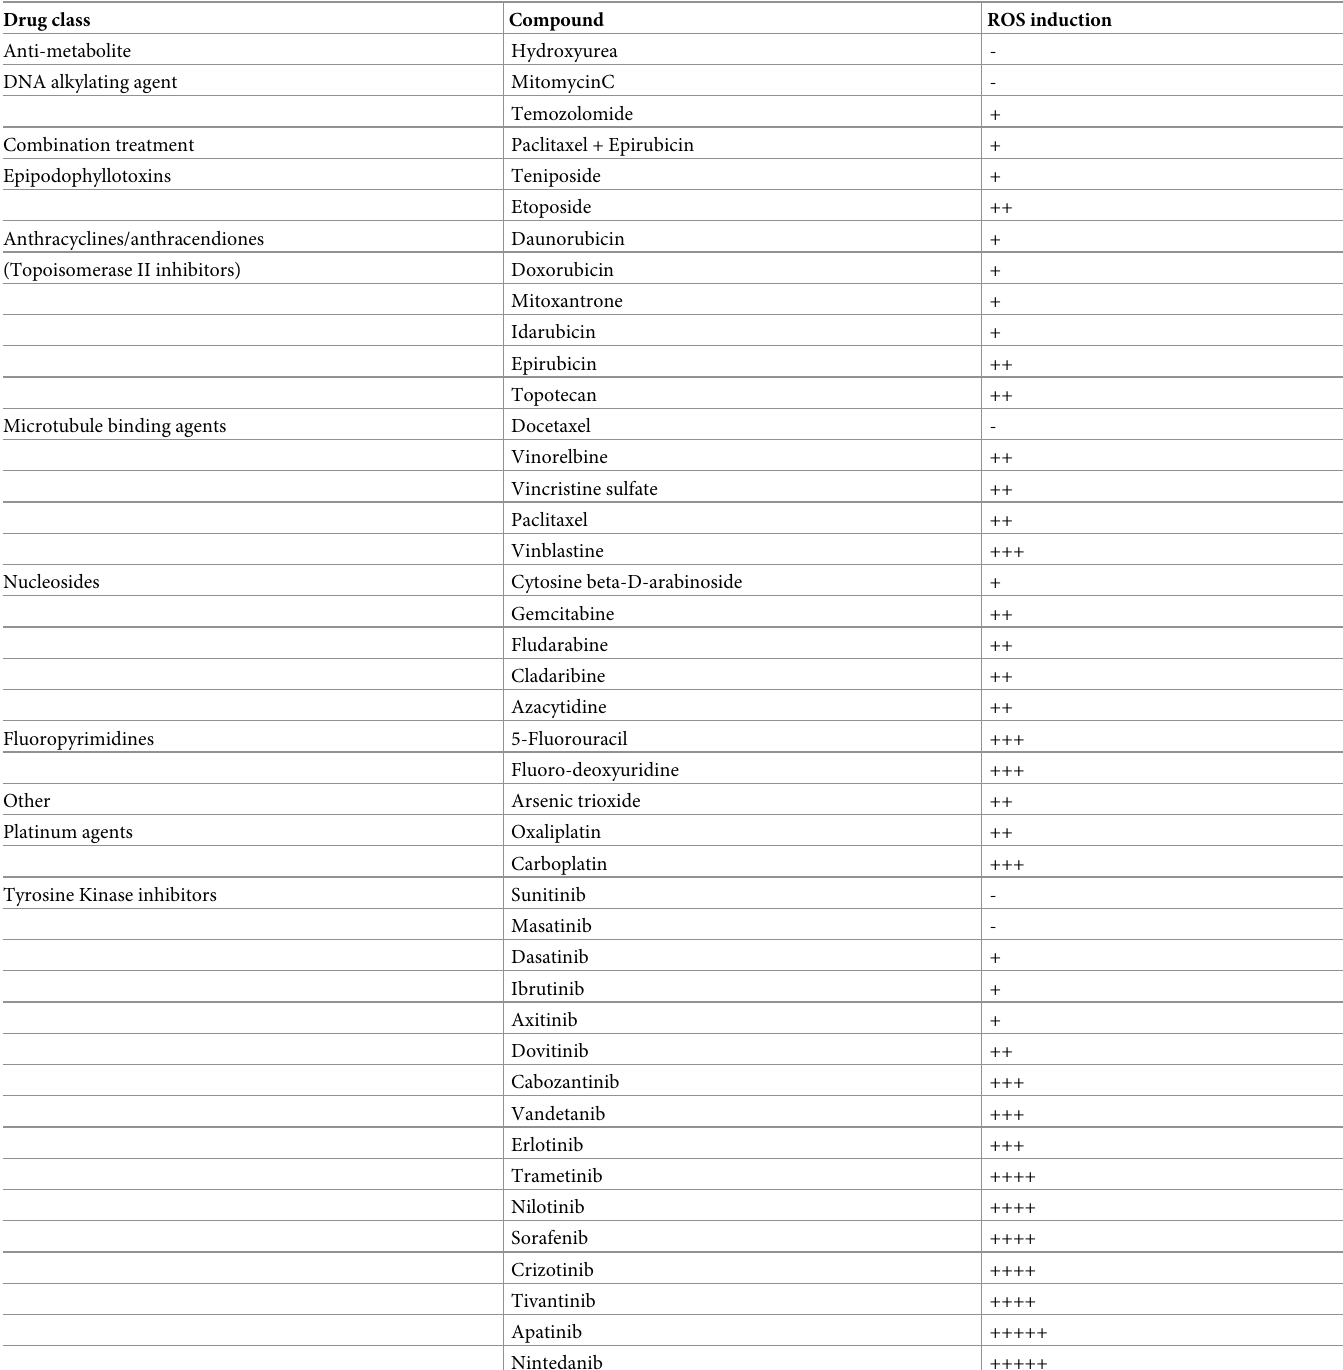
Table 4. Drug-induced oxidative stress results from ROS